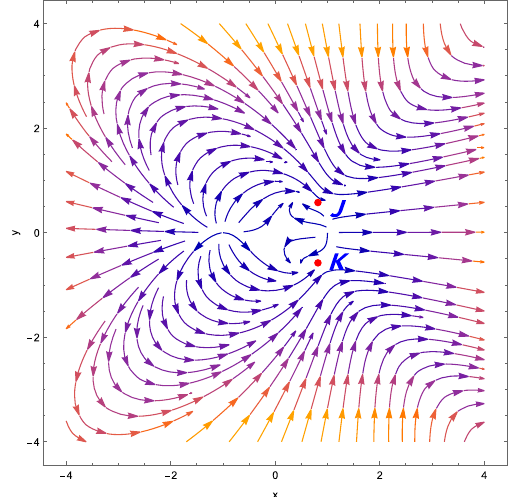
Fig. 7 The phase portrait is plotted for the parametric values λ = 2, u = 0, ρ = 0